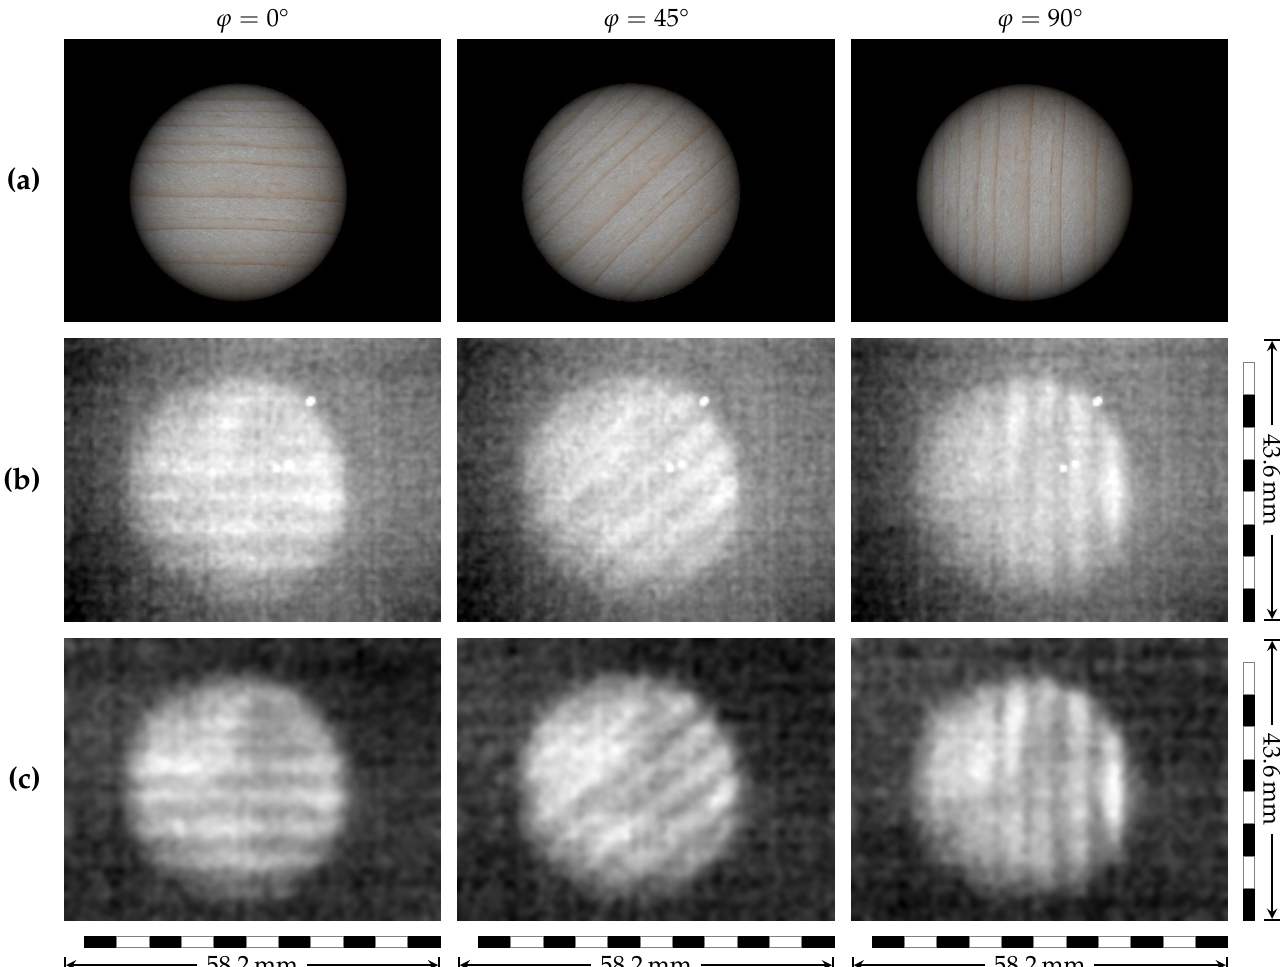
Figure 7. Imaging of a thin wood sample. ( a ) Not to scale artistic illustration of the approximate illumination of the thin wood sample for different angles ϕ , corresponding to the selected THz single frames from a full sample rotation recorded in real-time ( b , c ). Unprocessed data ( b ) as obtained from the camera and post-processed representation with dead pixel removal ( c